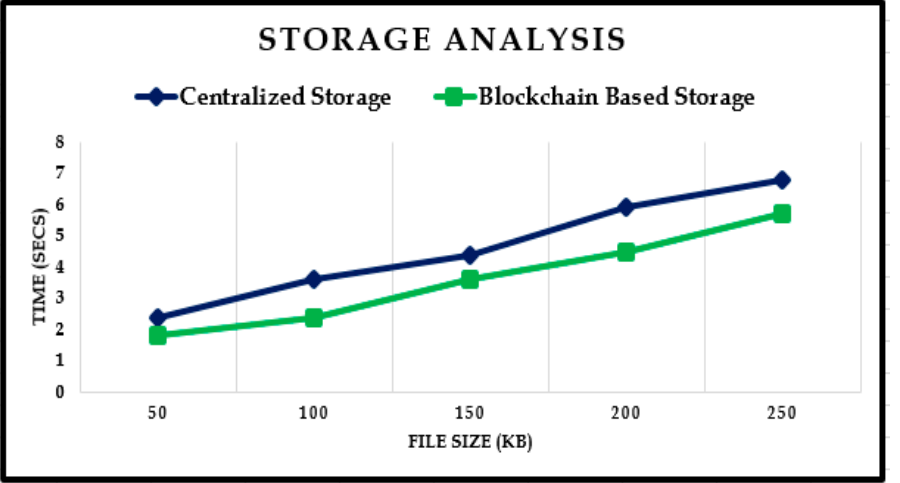
Figure 9. Time Required to Access the Data on the Cloud versus the Blockchain.